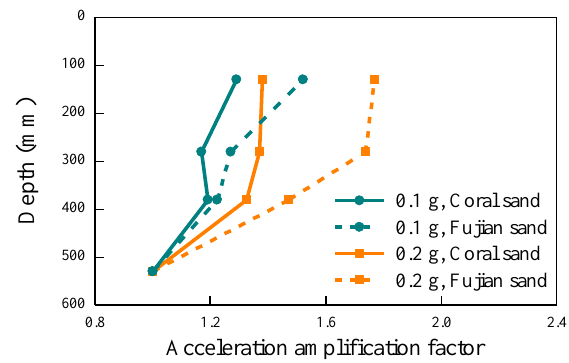
Figure 10. Acceleration amplification factors at different depth.